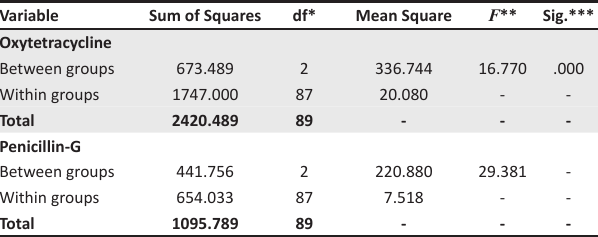
TABLE 2: Result of data analysis using one-way Analysis of variance. Variable Sum of